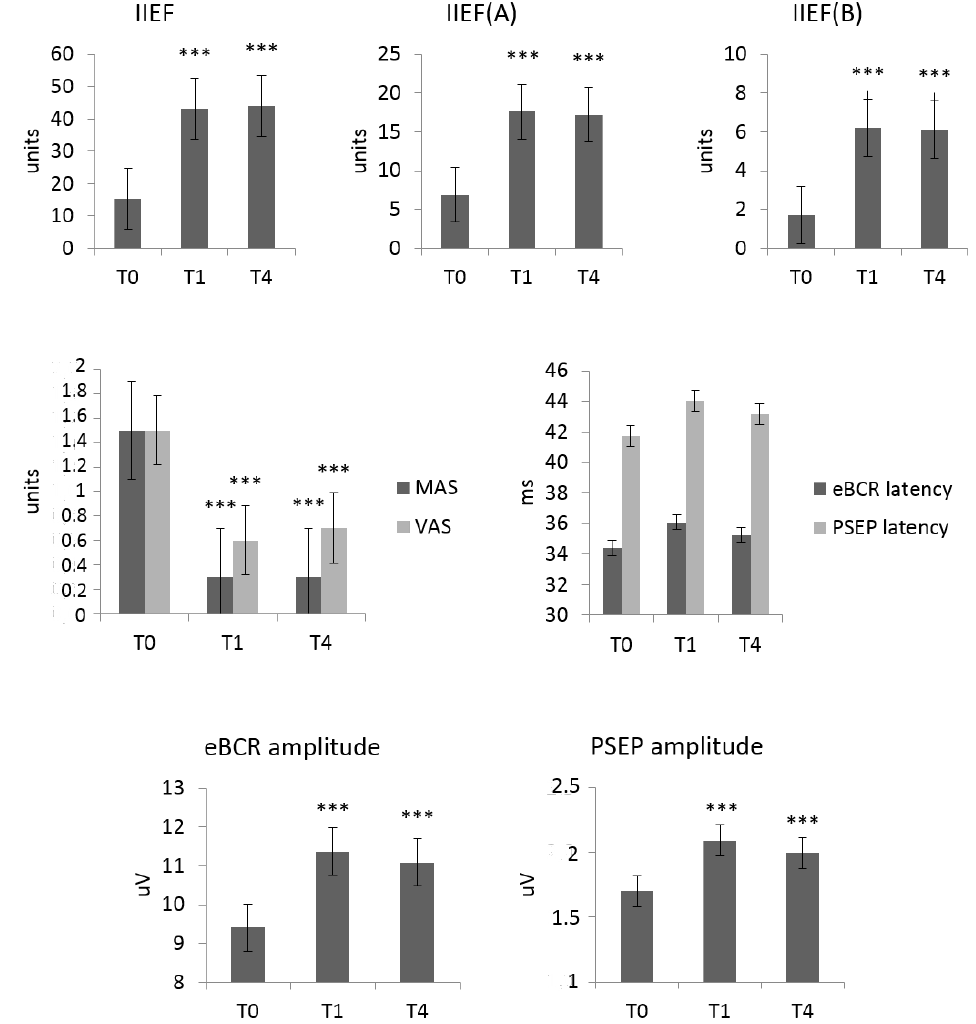
Figure 4. Clinical and electrophysiological aftereffects of pelvic muscle vibration at T0 (baseline), T1 (post-treatment) and T4 (3 months after the end of the treatment). Significance (*) was tested between T1 and T0 and T4 and T0 (*** p < 0.001). Vertical bars indicate s.d. IIEF—International Index of Erectile Function (A—erectile function, B—orgasmic function); eBCR—electrophysiological bulbocavernosus reflex; MAS—Modified Ashworth Scale; VAS—visual Analogue Scale for pain esteem; PSEP—pudendal nerve somatosensory-evoked